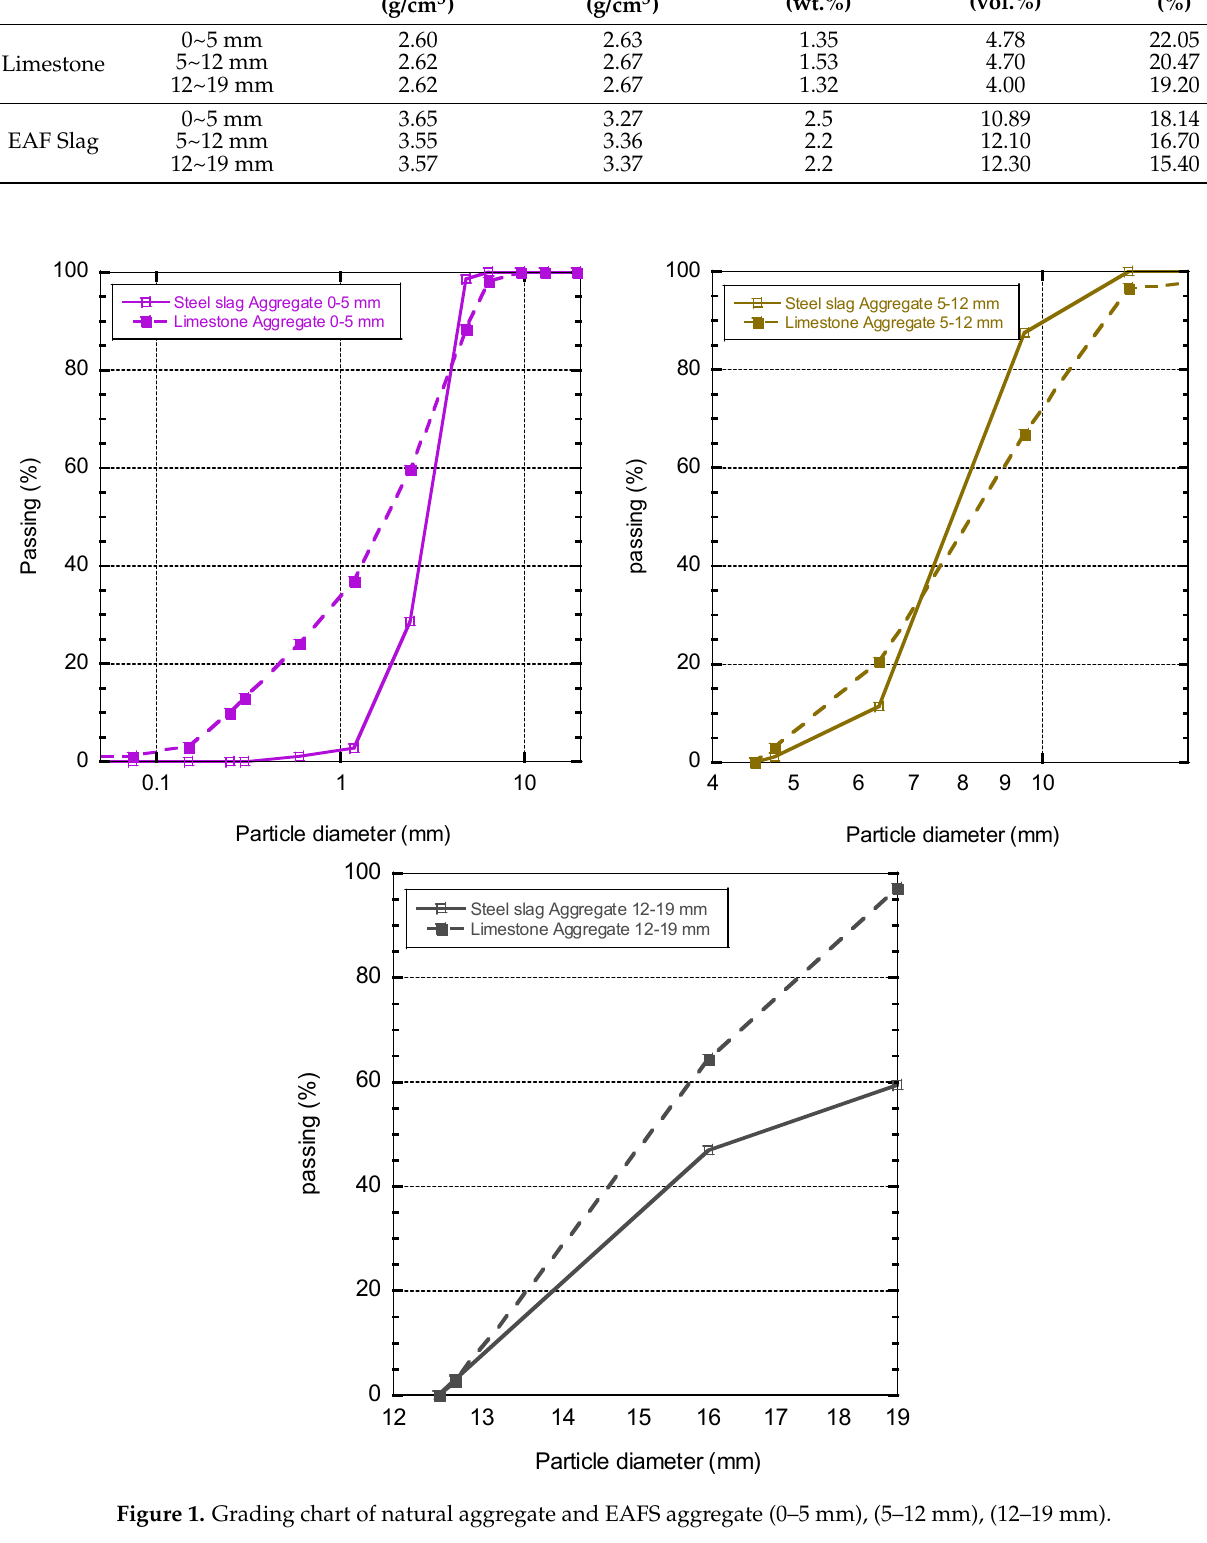
Figure 1. Grading chart of natural aggregate and EAFS aggregate (0–5 mm), (5–12 mm), (12–19 mm).